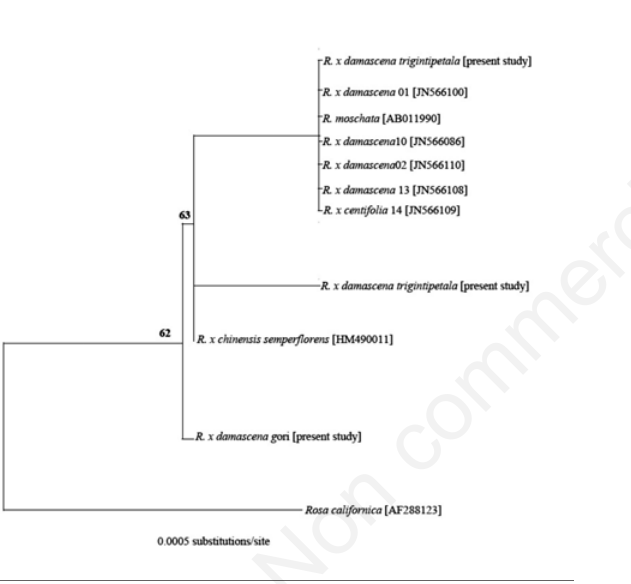
Figure 1. A neighbor-joining tree constructed from 722 bp matK gene fragment sequenced in this study. The values at some nodes refer to the bootstrapping of maximum-parsimony, neighbor- joining and maximum-likelihood analyses. The numbers between brackets are the accession numbers of the sequences collected from the Genbank